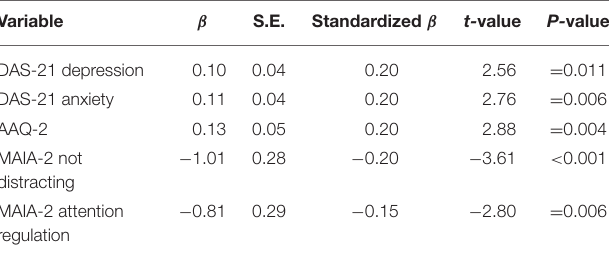
TABLE 6 | Model summary where alexithymia DIF is DV.